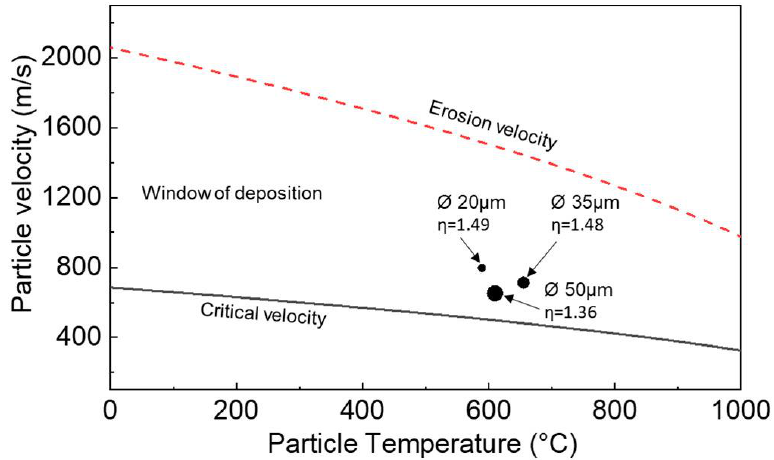
Figure 6. A visualization of the window of deposition of IN 625 alongside the particle velocity of various particle sizes. Reprinted from Wu et al. [75], Copyright 2021, with permission from Elsevier.